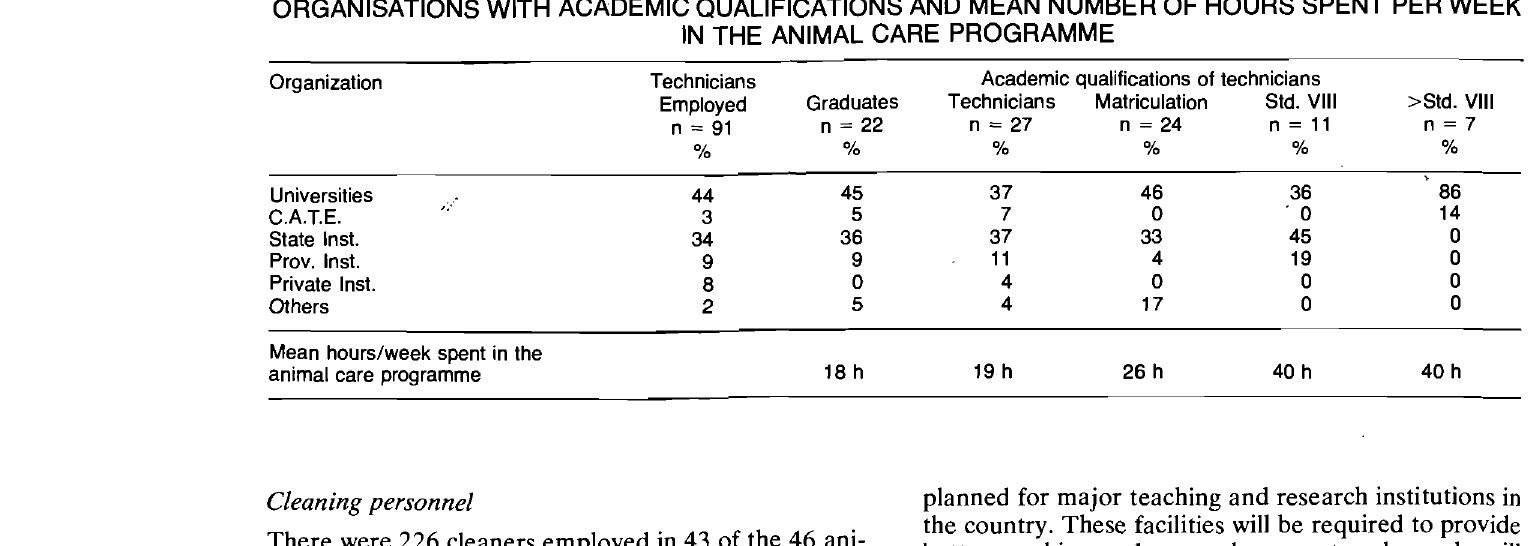
Table 6: NUMBERS AND PERCENTAGES OF TECHNICAL PERSONNEL EMPLOYED BY VARIOUS ORGANISATIONS WITH ACADEMIC QUALIFICATIONS AND MEAN NUMBER OF HOURS SPENT PER WEEK IN THE ANIMAL CARE PROGRAMME